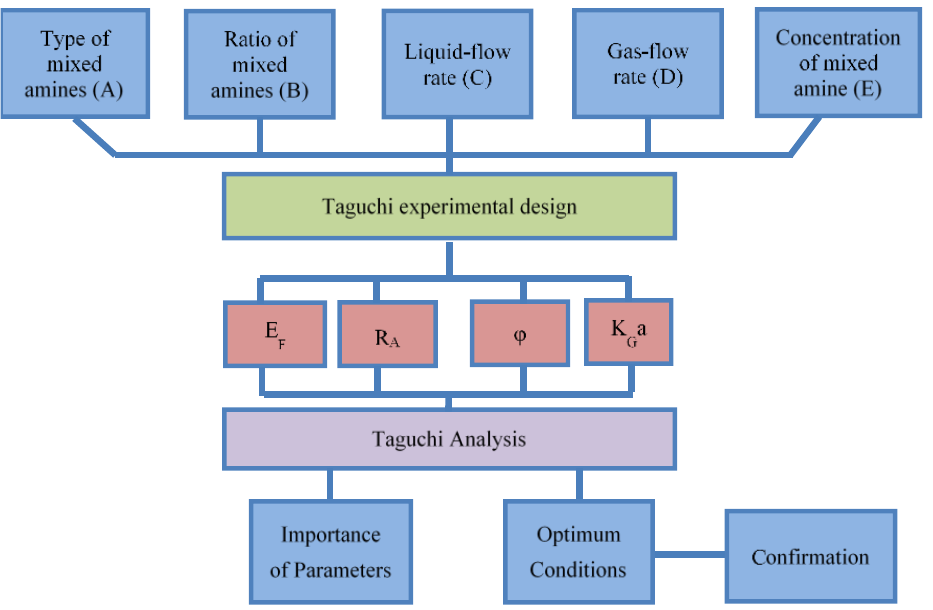
Figure 1. Framework of research conducted in this study.